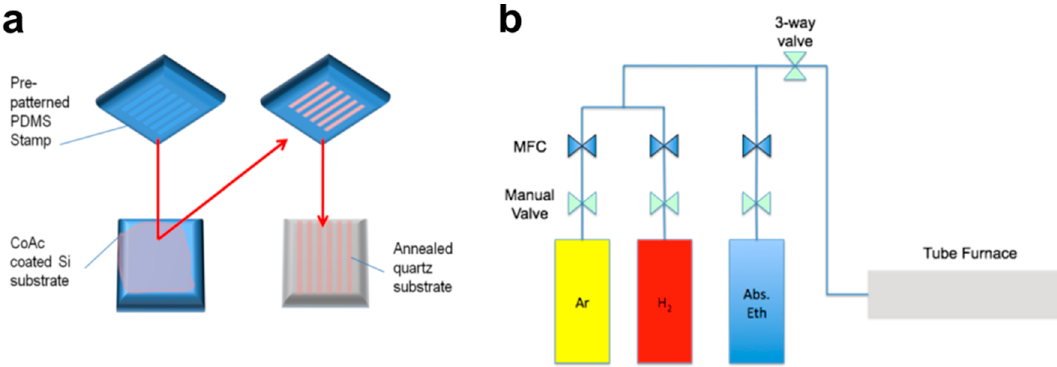
Figure 2. ( a ) Deposition of catalyst on quartz substrate using a polydimethylsiloxane stamp; ( b )